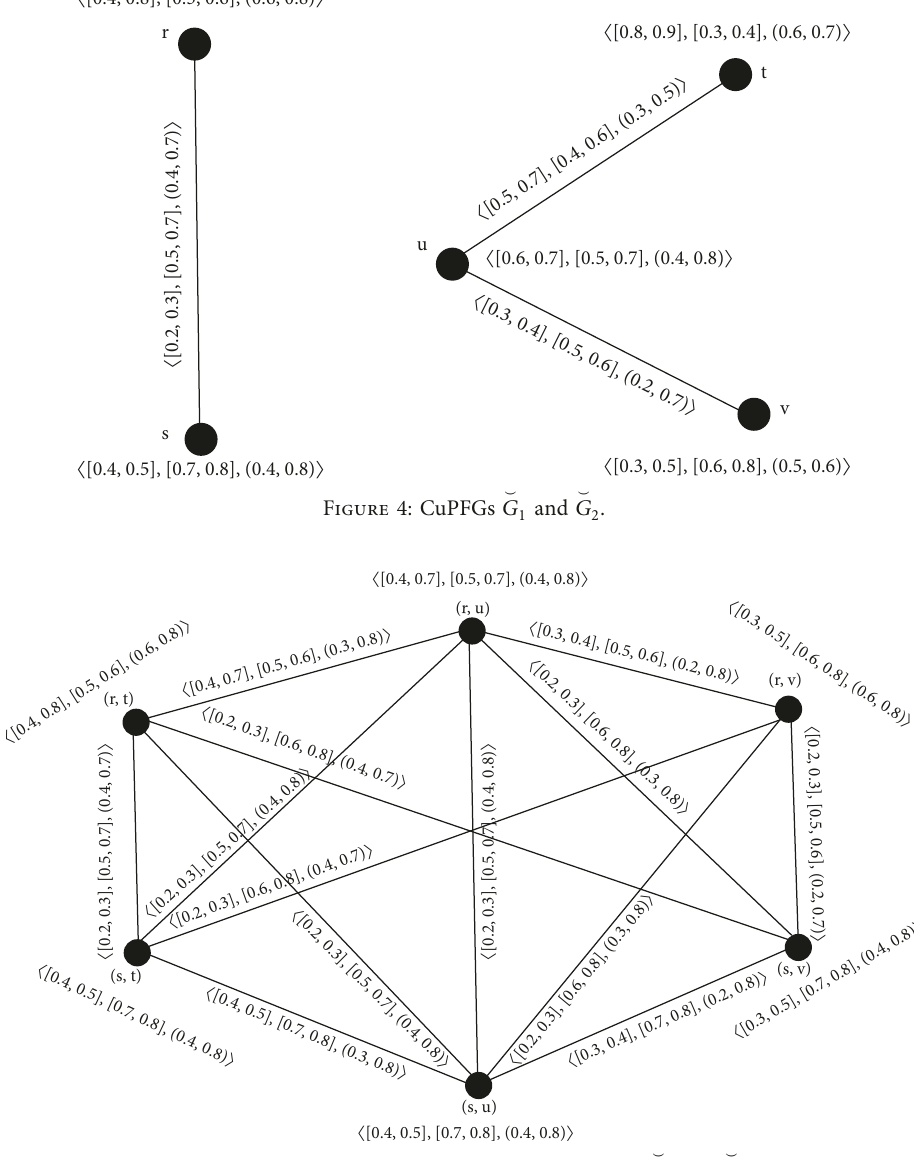
Figure 5: Lexicographical product of two CuPFGs G ⌣